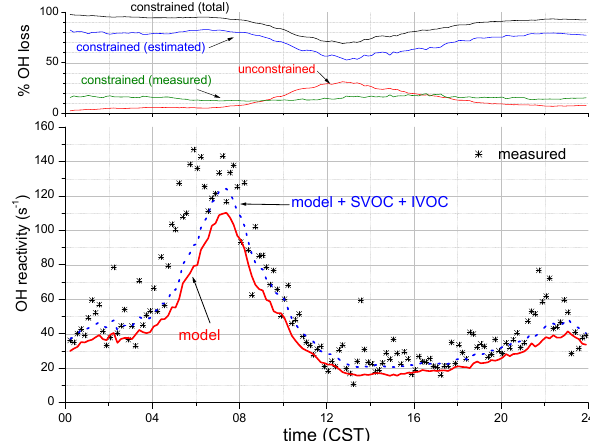
Fig. 2. The bottom panel shows the median measured (stars) and modeled (red solid line) OH loss; we also include a plot of mod- eled OH loss augmented with an estimated OH loss due to pri- mary organic aerosol (POA) vapors (SVOC+IVOC) as parameter- ized by Robinson et al. (2007). Note the under-estimation of OH loss by the model between 05:00–07:00. In the upper panel, the profile of OH loss in the model is separated into constrained pa- rameters (black line) and unconstrained parameters (red line). The constrained parameters are further distinguished as parameters con- strained by measurements (green line) and those that were estimated (blue line) based on emissions information in the literature. Con- strained parameters account for some 75–98% of total modeled OH loss throughout the